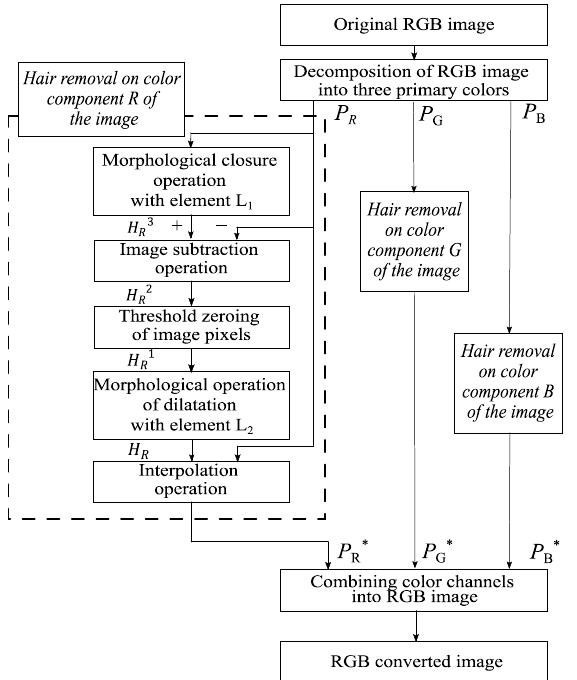
Figure 3. Scheme of the proposed method of identification and hair removal from dermatoscopic images of pigmented skin lesions.